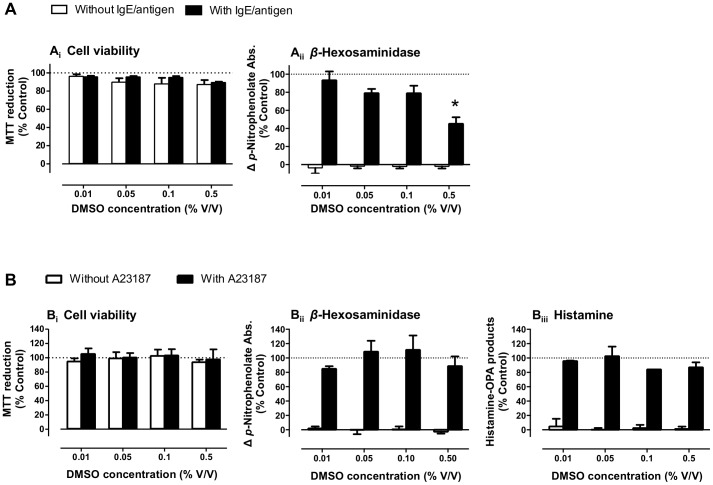
Solvent (DMSO) effect on RBL-2H3 basophils' degranulation assays.Effects of DMSO on cell viability (i), β-hexosaminidase (ii) and histamine release (iii) in cells stimulated with IgE/antigen (A) or with calcium ionophore (A23187) (B), n = 3–4. *P<0.05, One way ANOVA with Bonferroni post-hoc (vs. control).